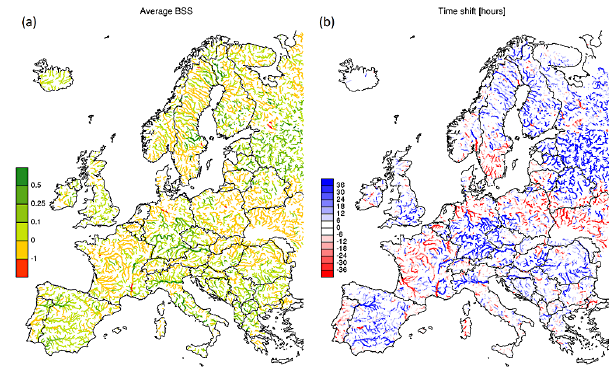
Figure 4. Average BSS among the considered lead times (a) and corresponding time shift of the ERI against the simulated threshold exceedances (b) .